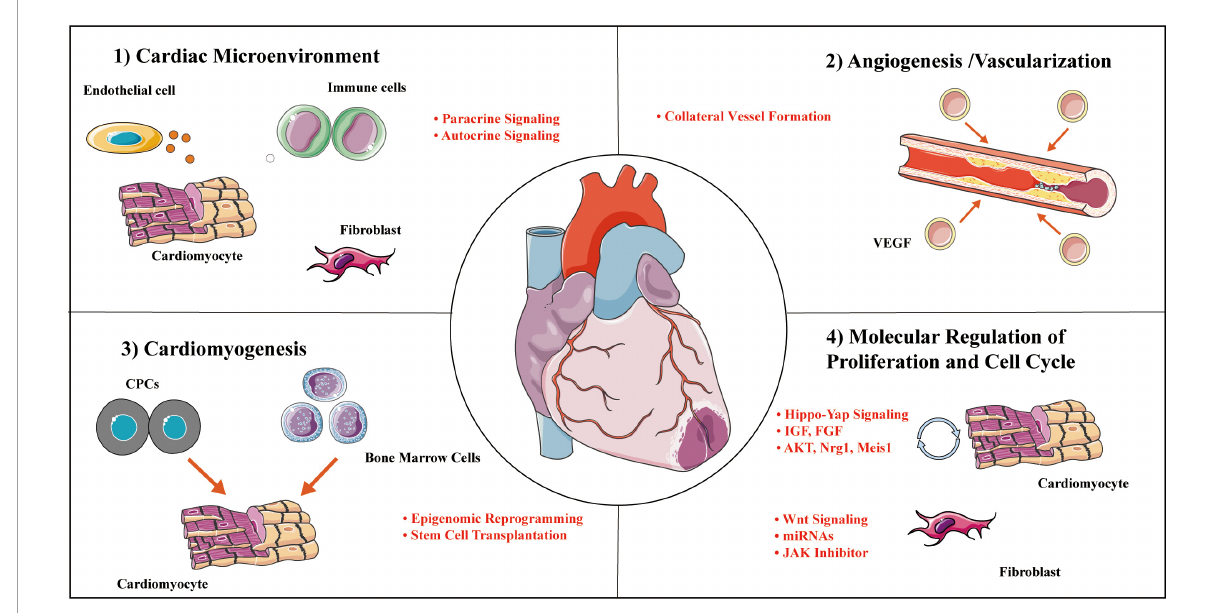
FIGURE4 Cardial regeneration involves multiple mechanisms. Representative categories and selected examples of processes to enhance cardial regeneration covered in this review. Mechanisms work independently on a molecular level to collectively mediate concurrent cellular actions